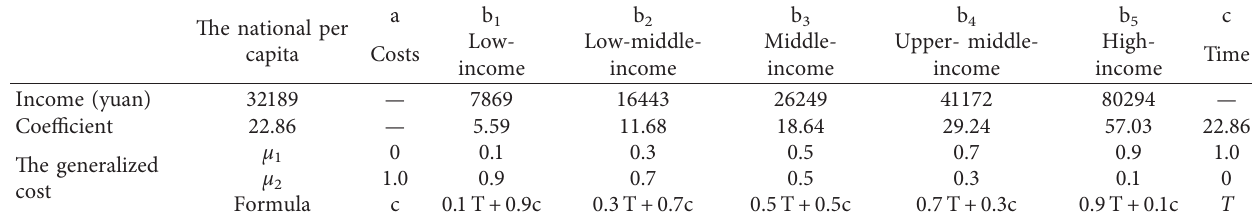
Table 4: The time value coefficient of different income groups in China.